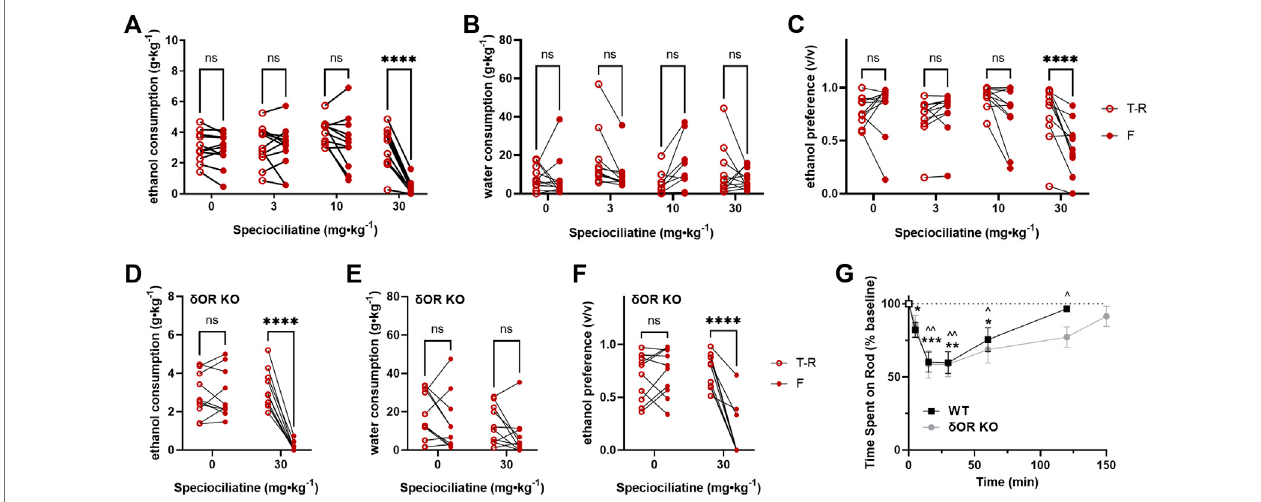
FIGURE 4 | Speciociliatine decreases voluntary ethanol consumption and impairs motor coordination in wild-type and δ OR knockout mice. 10% ethanol consumption, water consumption and ethanol preference in male C57BL/6 (A – C , respectively) ( n (cid:2) 11) and δ OR KO (D – F , respectively) mice ( n (cid:2) 10) in a voluntary twobottle choice, limited access, drinking-in-the-dark paradigm, following treatment with speciociliatine (3, 10, and 30 mg · kg ⁻ 1 , i.p.) (G) 150-minute duration rotarod assessment of motor incoordination inWTmice ( n (cid:2) 8) and δ OR KO mice ( n (cid:2) 7), immediately followed by a 30 mg · kg ⁻ 1 dose of speciociliatine (i.p.); signi fi cance for WTmiceand δ ORKOmiceisdenotedwithstarsandcarets,respectively.Opencirclesaretheaverageintake/preferenceonthepreceding3days(baseline),andclosed circles are the intake on Fridays following drug exposure. * or ^ p < 0.05, ** or ^ p < 0.01, *** p < 0.001, **** p < 0.0001 (for details, see Supplemental Tables S6 – S8 ).